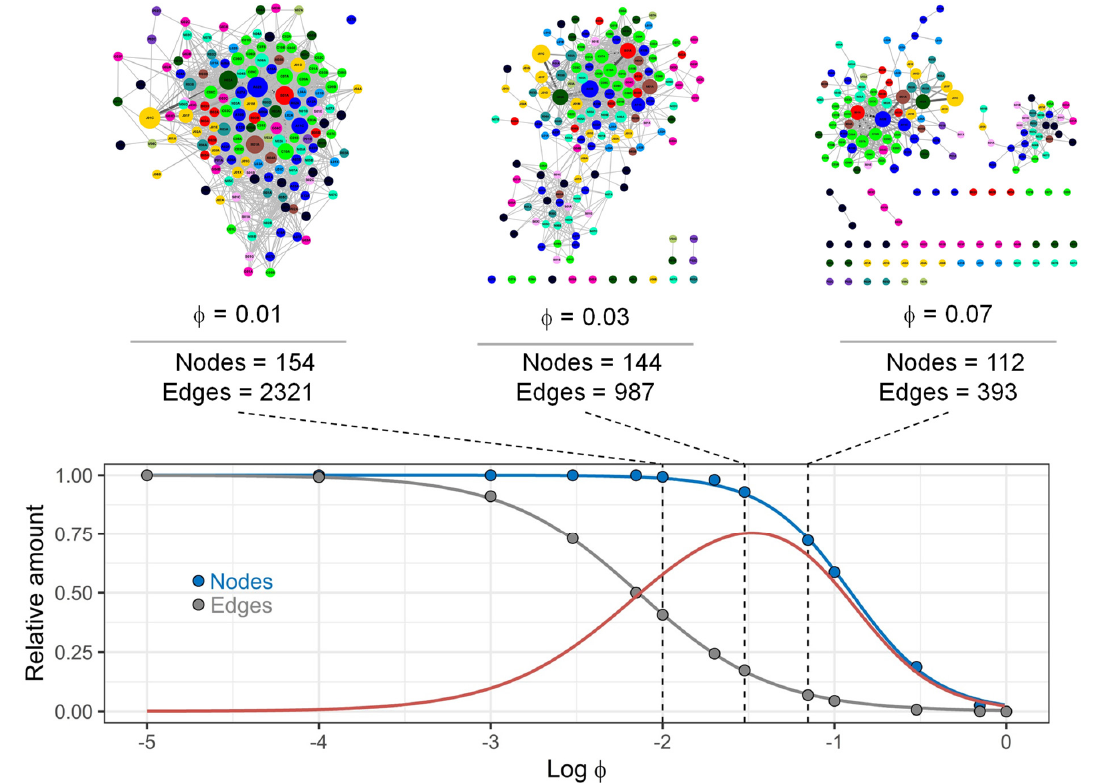
Figure 6. Relationship between φ -correlation and graph density. Drug prescription networks at the third ATC level were created by adopting different φ -correlation values (from 0.00001 to 1). The number of connected nodes (blue dots) and edges (grey dots) in these networks was determined and analysed using logistic models (blue and grey lines, respectively). The red curve displays the difference between the blue and the grey curves; the x -coordinate of its maximum is denoted φ max . Nodes are coloured according to the 14 groups found at the first level of the ATC classification